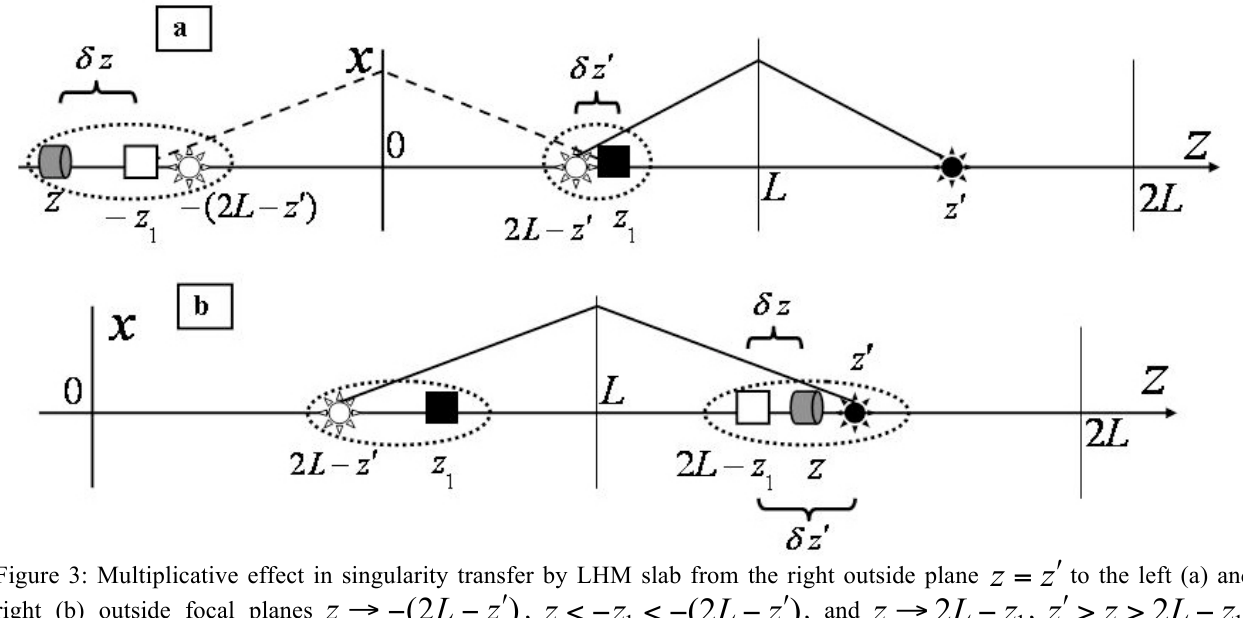
Figure 3: Multiplicative effect in singularity transfer by LHM slab from the right outside plane zz ʹ′ = to the left (a) and right (b) outside focal